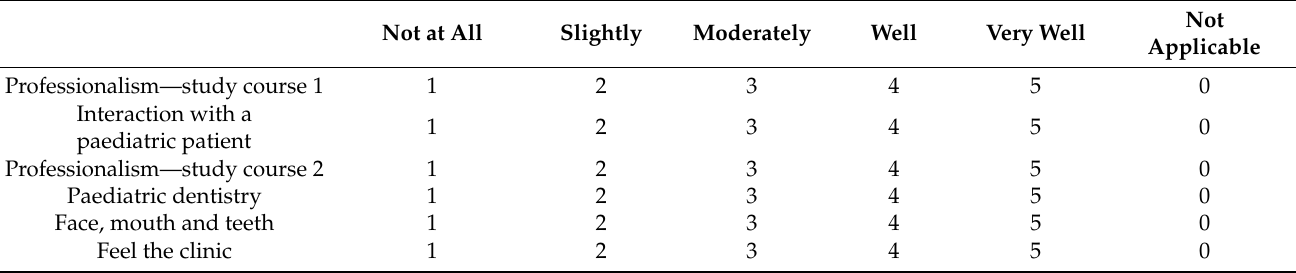
Table A3. II Studies designed specifically for dental students during the first two study years. Evaluate how the studies designed specifically for the dental students during the first two study years have formed basis for the clinical phase studies. Circle the option “Not applicable” if you have not attended to the study